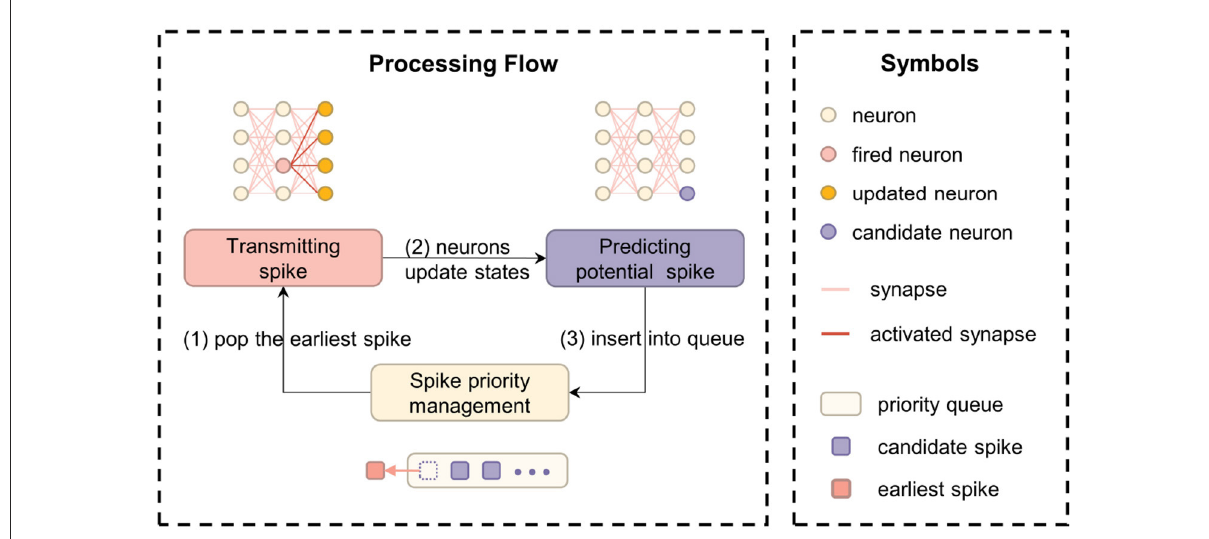
FIGURE1 The computational flow chart of EDHA and EvtSNN, which core task is to maintain the spike priority queue.